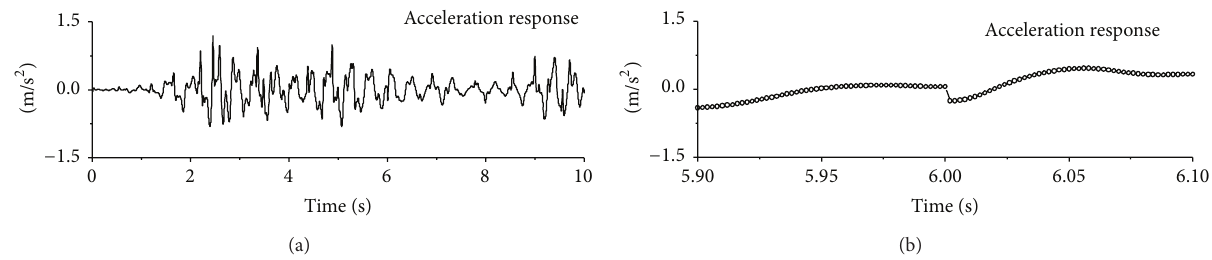
Figure 2: Signal discontinuity due to sudden damage (seismic excitation).